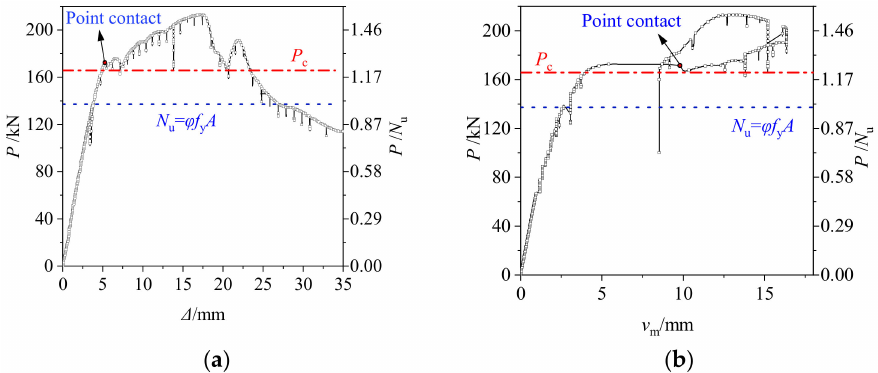
Figure 7. Experimental results: ( a ) P - ∆ relationship; ( b ) P - v m